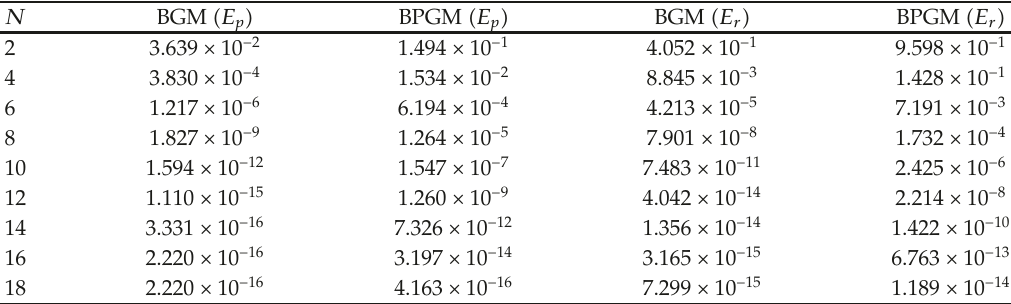
Table 1: E p and E r for N (cid:6) 2 , 4 ,... ,